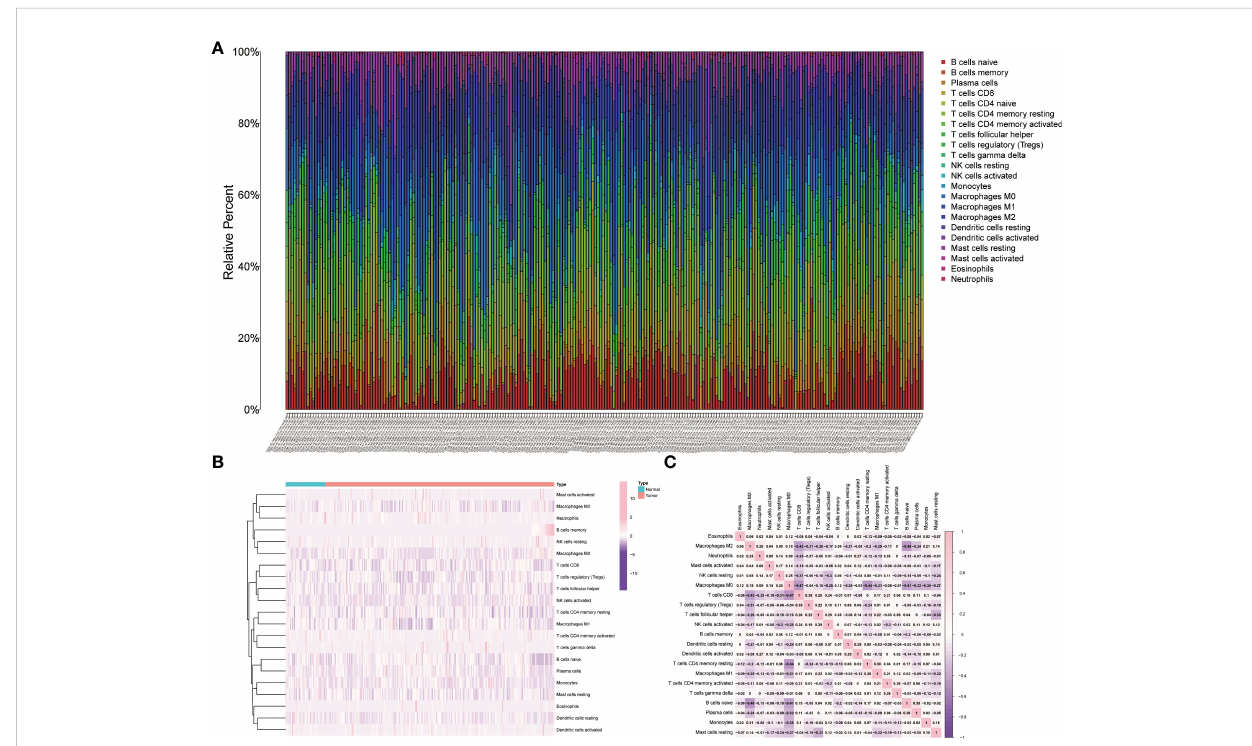
FIGURE 1 Relative analysis of immune cells in tumor samples and normal tissue. (A) The relative proportions of immune cells in the TCGA cohort. (B) The heatmap of the immune cells in the tumor samples and normal tissue. (C) The correlation analysis of in fi ltrative immune cells for the TCGA